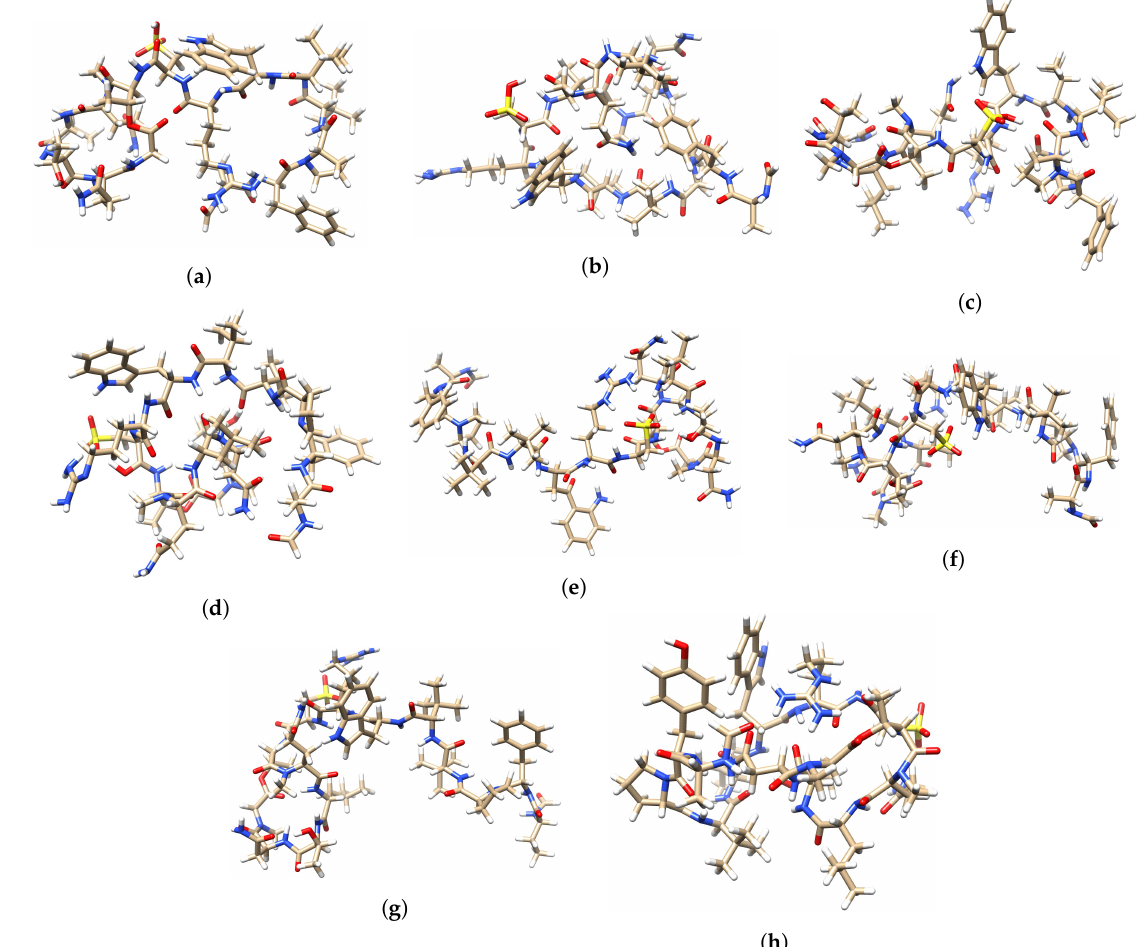
Figure 4. Optimized molecular structures of ( a ) Discodermin A, ( b ) Discodermin B, ( c ) Discodermin C,